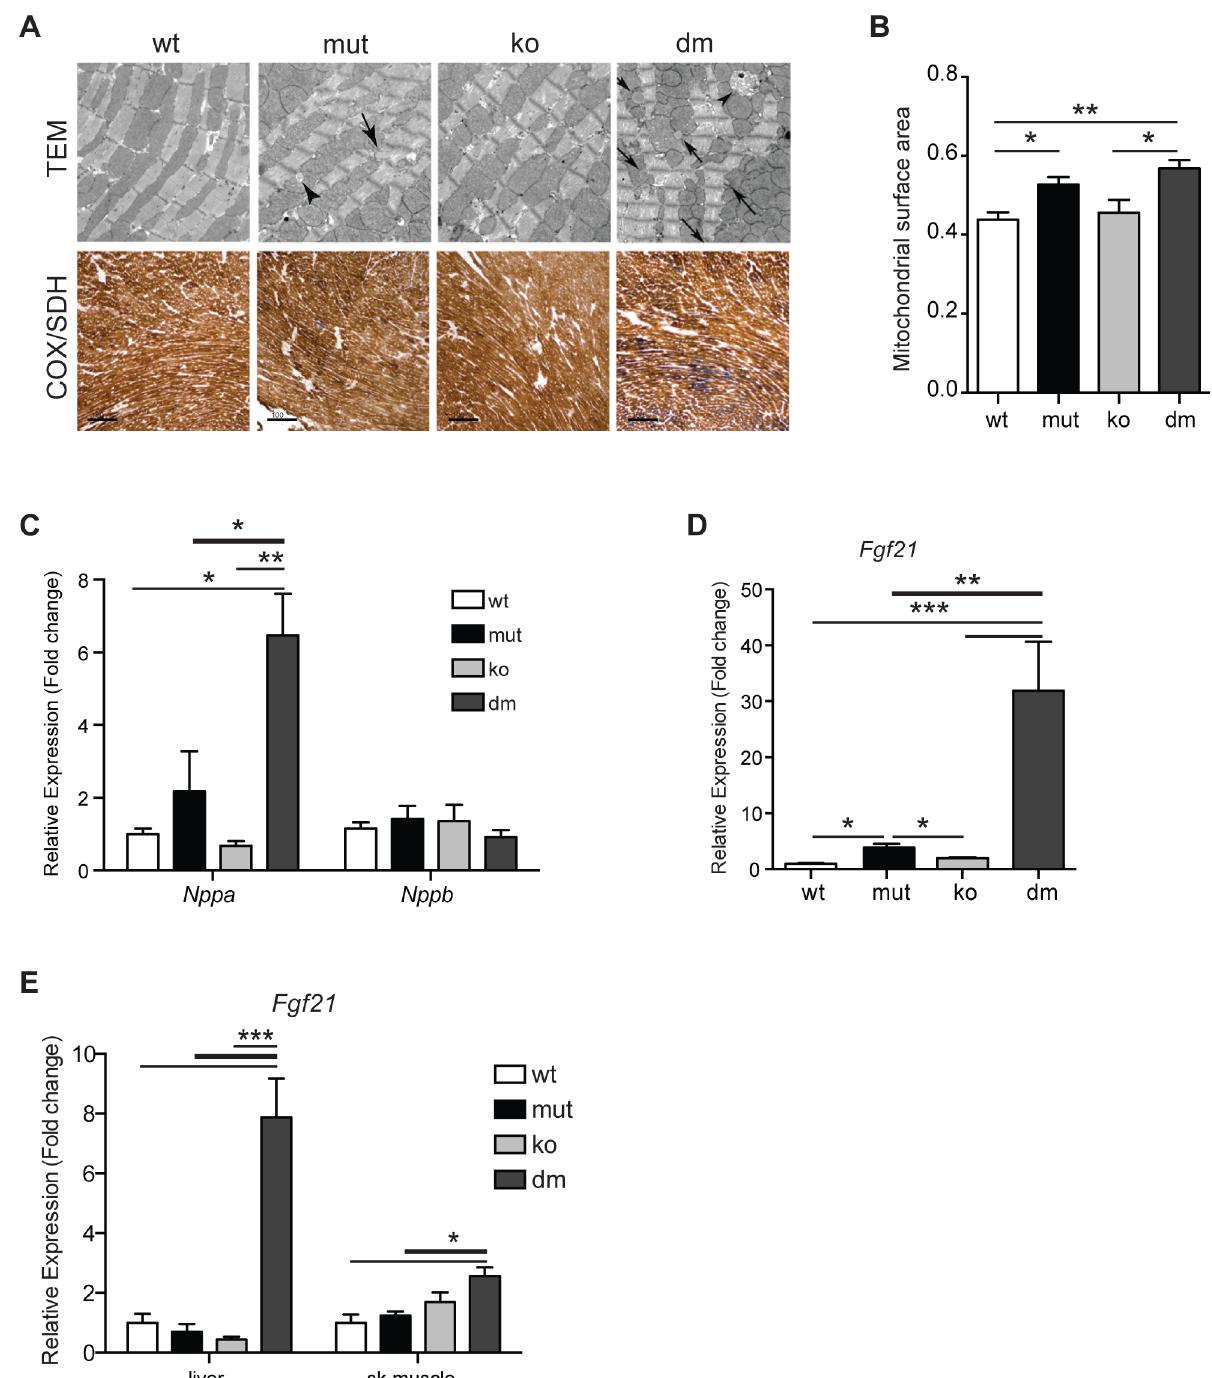
Figure 3. Characterization of mitochondrial cardiomyopathy in wild type (wt), mtDNA mutator (mut), UCP2-deficient wild type (ko) and mtDNA mutator (dm) mice. (A) Histological examination of cardiomyocytes from mut and dm mice. TEM – transmission electron micrographs. Arrows indicate lipid droplets, arrowheads abnormal mitochondria. COX/SDH - Enzyme histochemical staining for cytochrome c oxidase (COX) and succinate dehydrogenase (SDH) activities in heart. (B) Quantification of mitochondrial mass in transmission electron micrographs. (C) Relative expression levels of Nppa and Nppb , markers of heart failure. (D) Relative Fgf21 mRNA expression levels in heart. (E) Relative Fgf21 mRNA expression levels in liver and skeletal muscle. All analyses were performed on 25-week-old mice. Bars indicate mean level 6 standard error of the mean (S.E.M.). Asterisks indicate level of statistical significance (*p , 0.05 **p , 0.01 ***p , 0.001, Student’s t -test).